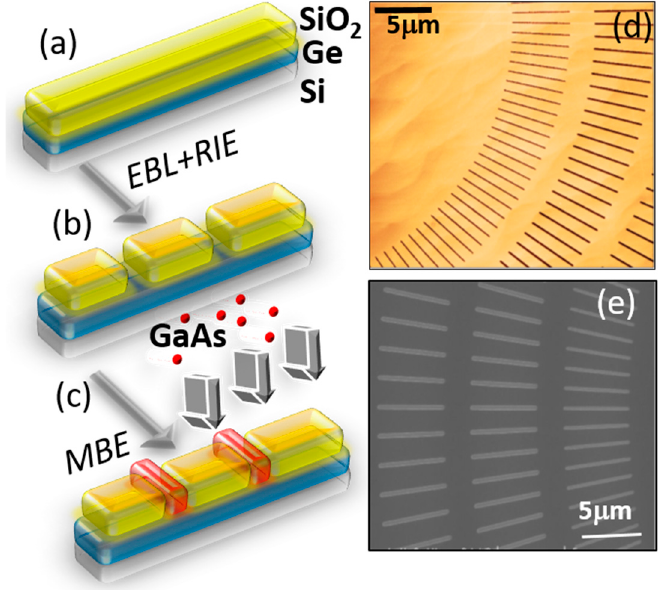
Figure 1. Graphic representation of sample preparation and subsequent SAE. ( a ) 1 μ m thick Ge film has been deposited by LEPECVD on the Si substrate. Then, a thin SiO 2 film has been evaporated by ALD. ( b ) By a combination of EBL and RIE, several patterns with different lengths, periodicity and complexity have been obtained in the SiO 2 mask. ( c ) Finally, a proper SAE is obtained showing the integration of III–V material through a patterned mask. ( d , e ) AFM and SEM images acquired in tapping mode and planar view respectively on patterned SiO 2 mask, where the relative etching depth is 30–32 nm. A circular pattern obtained by rotating a 5- μ m-long slit along circumferences of 60 µm, 90 µm and 120 µm radius respectively and for every 2° is